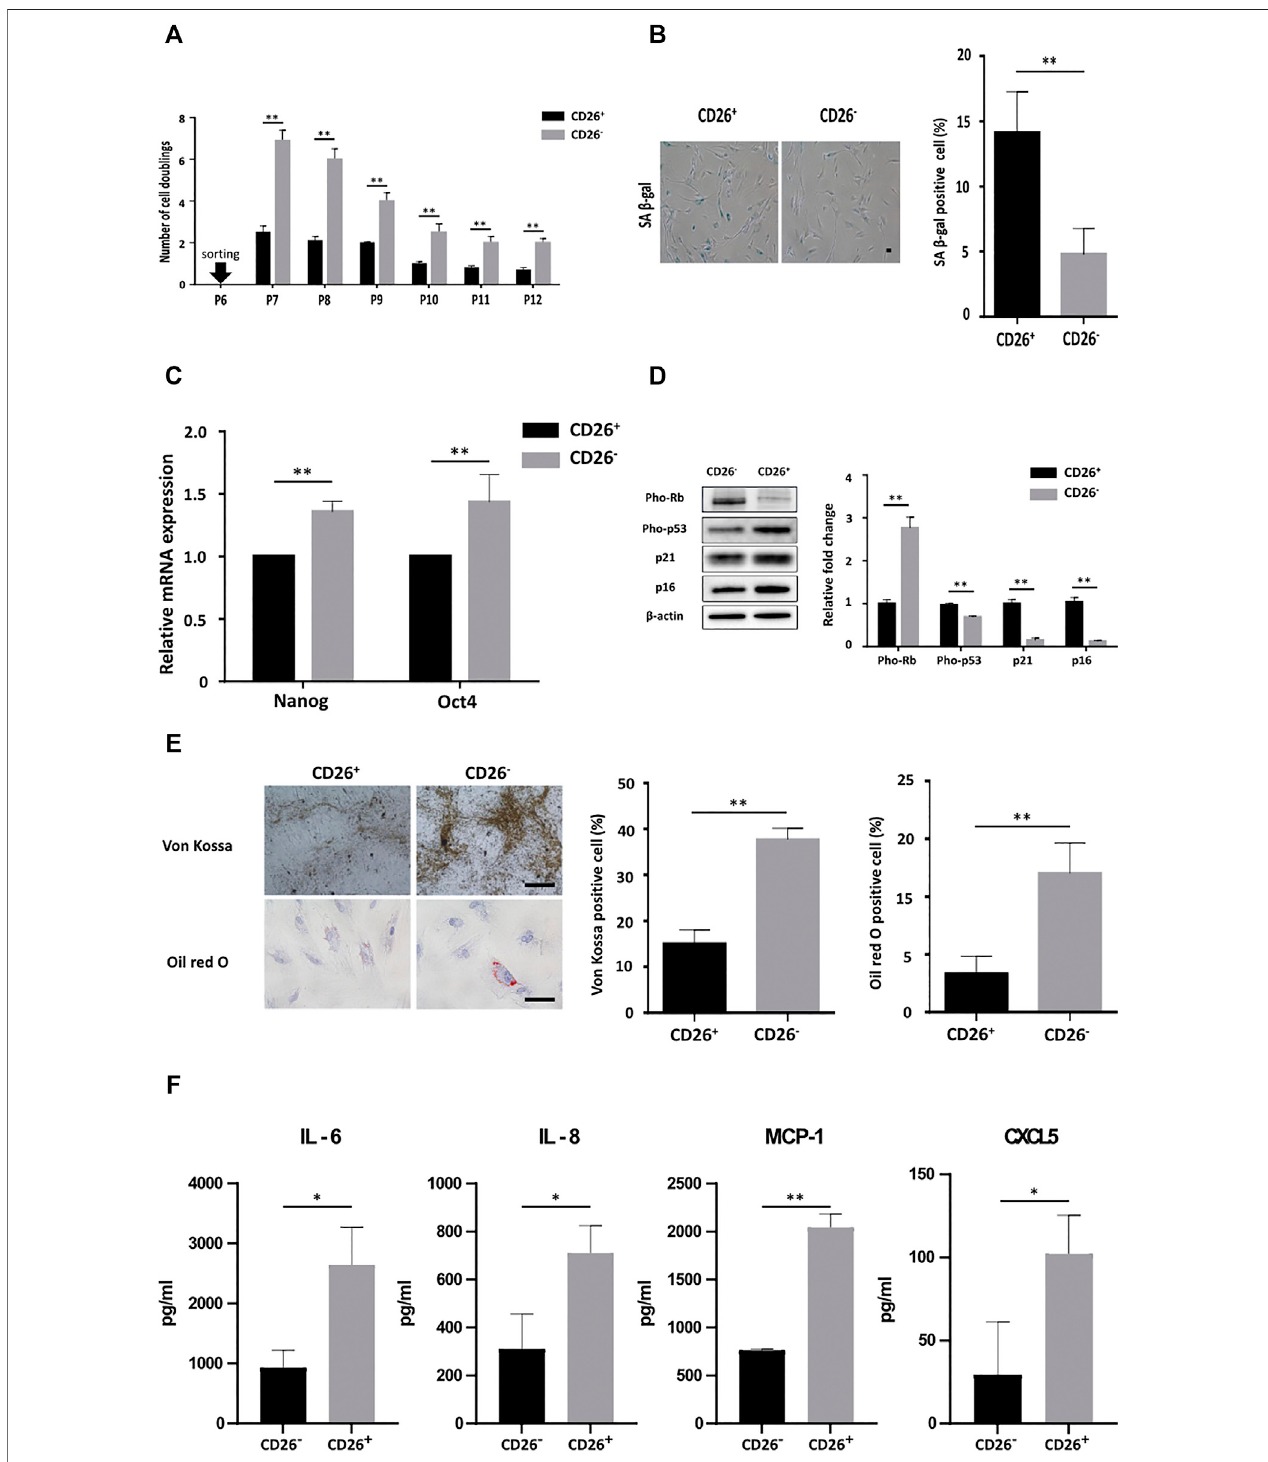
FIGURE4| hUCB-MSCswithlowCD26expressionshowsigni fi cantlydifferentsenescencephenotypeandsecretome. (A) NumberofcelldoublingsofhUCB-MSCsateach indicated passage after sorting in accordance with the expression of CD26 ( n (cid:1) 3). (B) Representative images (left) and bar graph (right) of SA β -gal stained CD26 + and CD26 − hUCB-MSCs ( n (cid:1) 4, passage 10); Scale bar, 50 μ m. (C) Relative mRNA expression of Oct4 and Nanog measured by RT-qPCR in CD26 + and CD26 − hUCB-MSCs ( n (cid:1) 3). (D) Immunoblotting images (left) and densitometry (right) of senescence-associated proteins in CD26 + and CD26 − hUCB-MSCs ( n (cid:1) 3, passage7). ( E) Representative images (left) and bar graph (right) of Von Kossa and Oil red O stained CD26 + and CD26 − hUCB-MSCs ( n (cid:1) 3, passage 7) Scale bar, 25 μ m. (F) Multiplex human cytokine analysis of conditioned medium from CD26 + or CD26 − hUCB-MSCs ( n (cid:1) 3, passage 7). Abbreviation: hUCB-MSCs, human umbilical cord blood mesenchymal stem cells; SA β -gal, senescence-associated β galactosidase; RT-qPCR, quantitative reverse transcription PCR. * p < 0.05; ** p < 0.01.